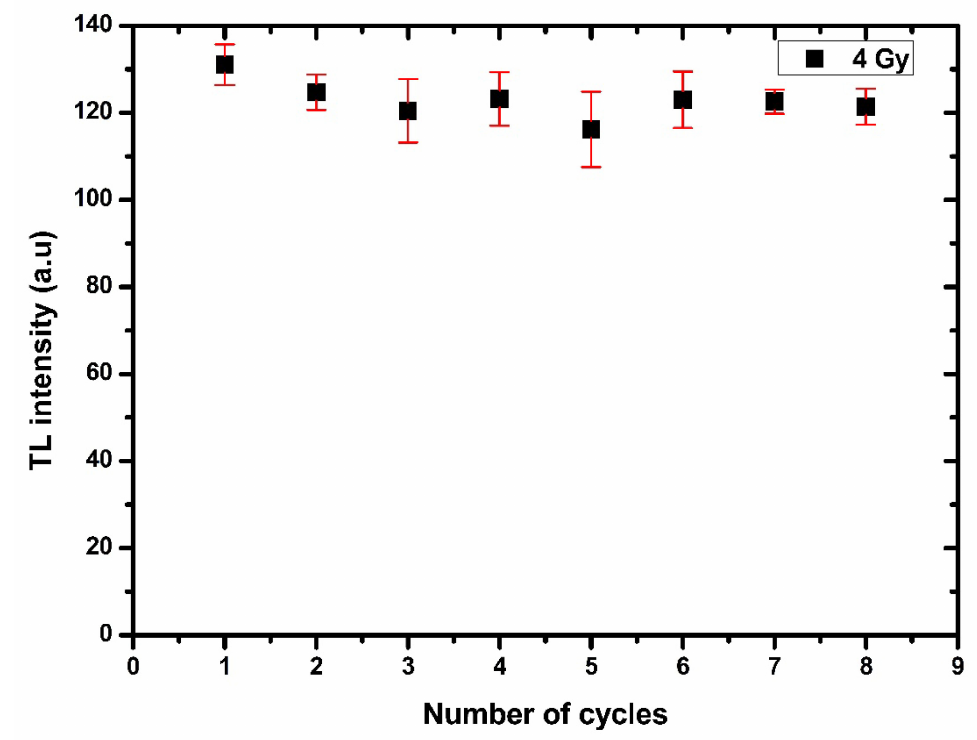
Figure 14. Reproducibility of Ag-doped ZnO thin films irradiated 4 Gy with